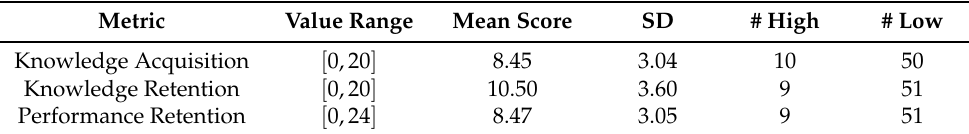
Table 3. Evaluation metrics and categorizations of